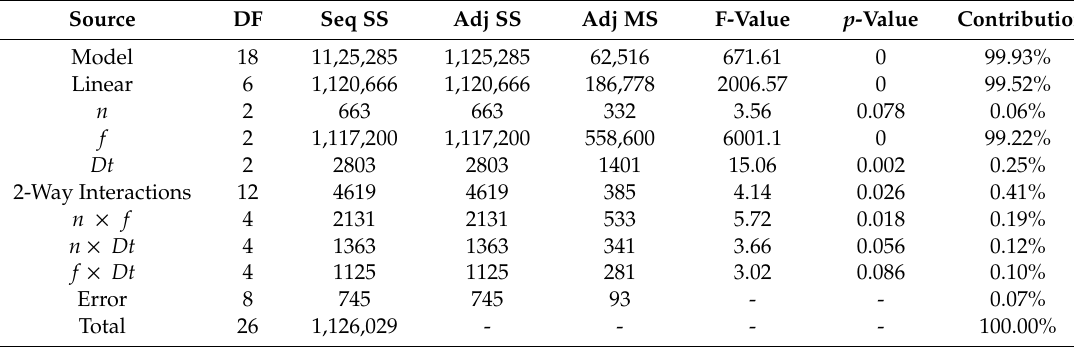
Figure 2. Average thrust force Table 2. ANOVA for thrust force.